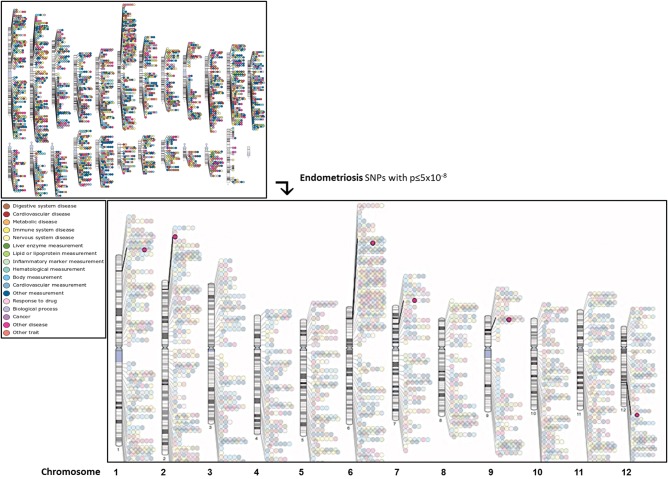
Schematic overview of all genome-wide associations (P ≤ 5 × 10−8) across all chromosomes (small window) and endometriosis associations (large window), presented in 17 trait categories (colour coded), generated from the NHGRI GWA Catalog (Hindorff et al., 2009). Available at: www.genome.gov/gwastudies (accessed 11 October 2013).